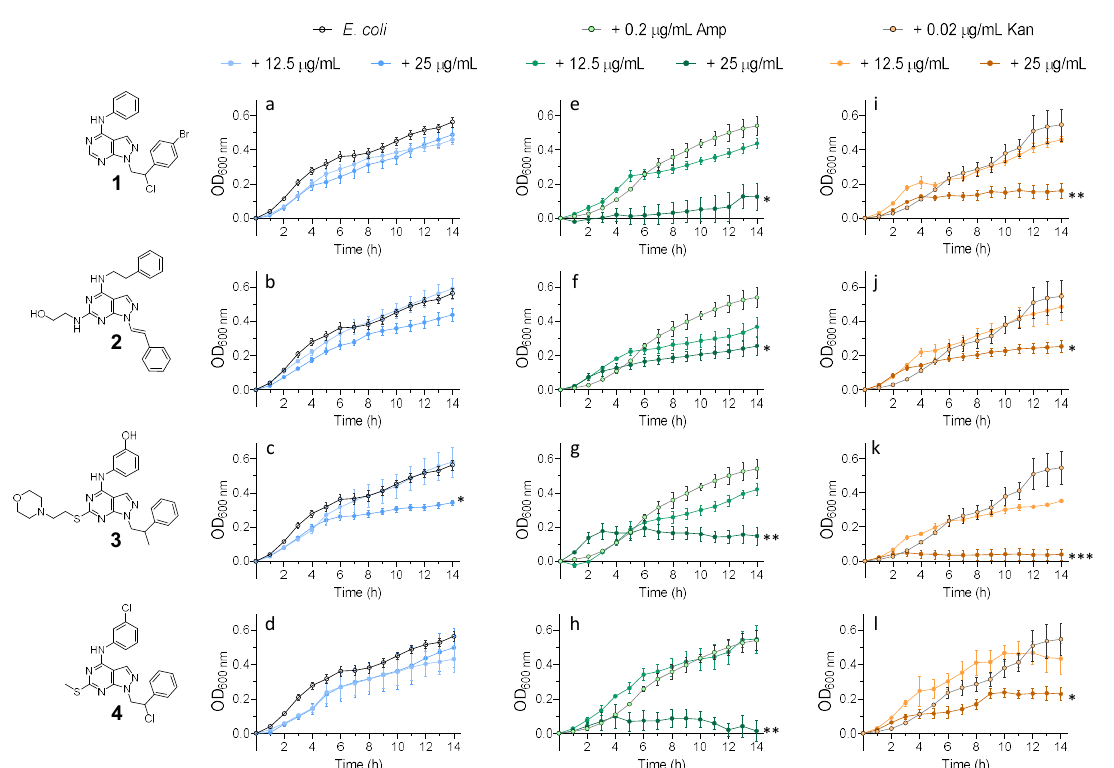
Figure 6. Growth curves of E. coli grown in the presence of ( a – d ) pyrazolo[3,4- d ]pyrimidines (12.5 and 25 µ g / mL), ( e – h ) pyrazolo[3,4- d ]pyrimidines (12.5 and 25 µ g / mL) in the presence of a sublethal dose of ampicillin (0.2 µ g / mL) and ( i – l ) pyrazolo[3,4- d ]pyrimidines (12.5 and 25 µ g / mL) in the presence of a sublethal dose of kanamycin (0.02 µ g / mL). p -values of significance (* < 0.05, ** < 0.01 and *** < 0.001) were determined using one-way analysis of variance (ANOVA). Data are representative of at least 3 independent repeat experiments. Error bars indicate SEM. OD: optical density.